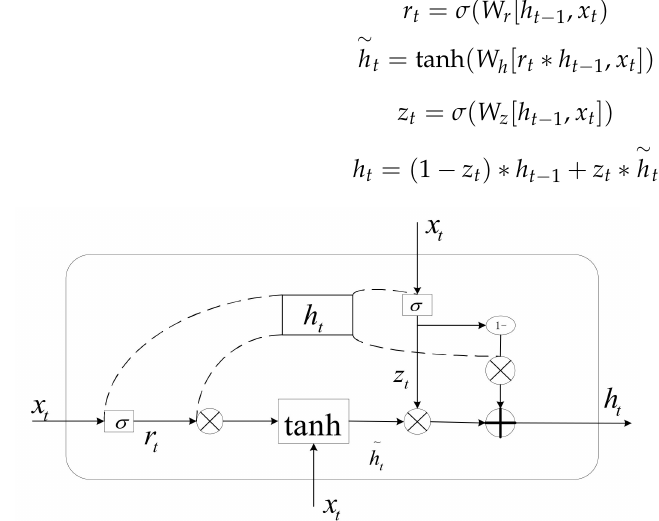
Figure 1. GRU structure